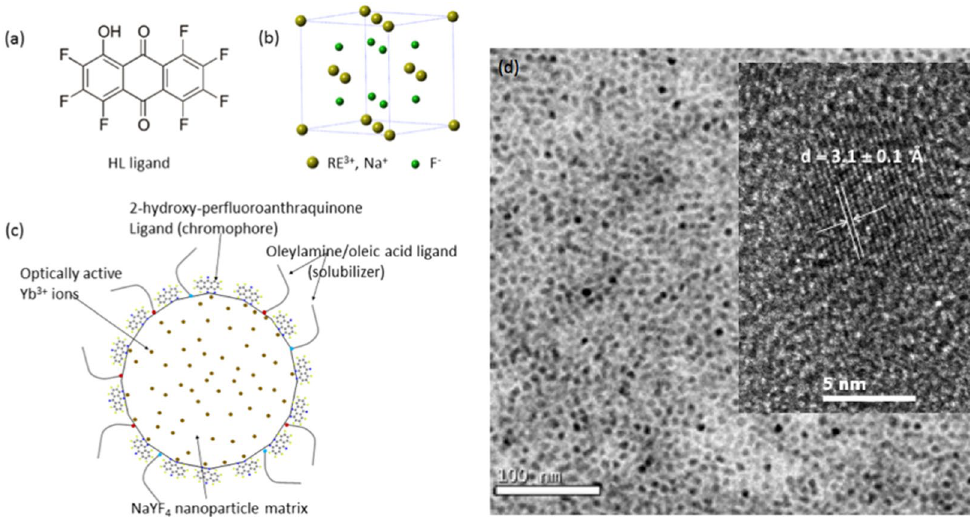
Figure 1. ( a ) Scheme of 2-hydroxy-perfluoroanthraquinone neutral ligand; ( b ). Cubic NaYF 4 structure; ( c ). Chromophore-capped Yb 3 + -doped NaYF 4 nanoparticles (proportions of the components’ sizes are approximately respected; ( d ). TEM and HRTEM (inserted) images of the 10% Yb 3 + -doped NaYF 4 nanoparticles. The observed interplanar distance is given and found in agreement with that expected for the (1 1 1)